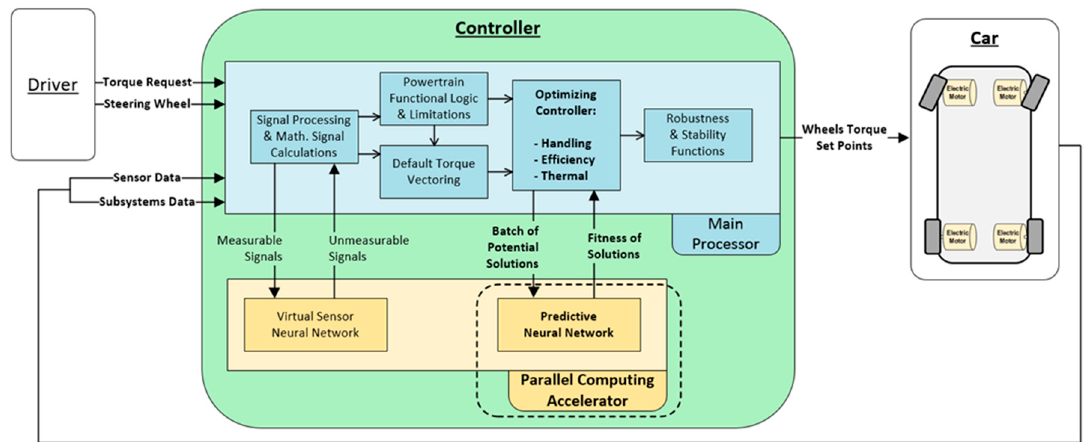
Figure 4. Diagram from the control system perspective representing the targeted vehicle with 4 electric motors, illustrating a simplified block diagram of the algorithms and highlighting its objectives for the application.